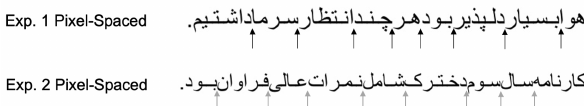
Figure 3. The Pixel-Spaced conditions in both experiments. The black arrows indicate where reducing the interword space, following the letters that do not connect to the next letter may have resulted in inaccurate word boundary cues in Experiment 1. The grey arrows indicate where the words’ final letters in Experiment 2 could be connected to the next letter, but were not, thus perhaps providing word segmentation cues to the